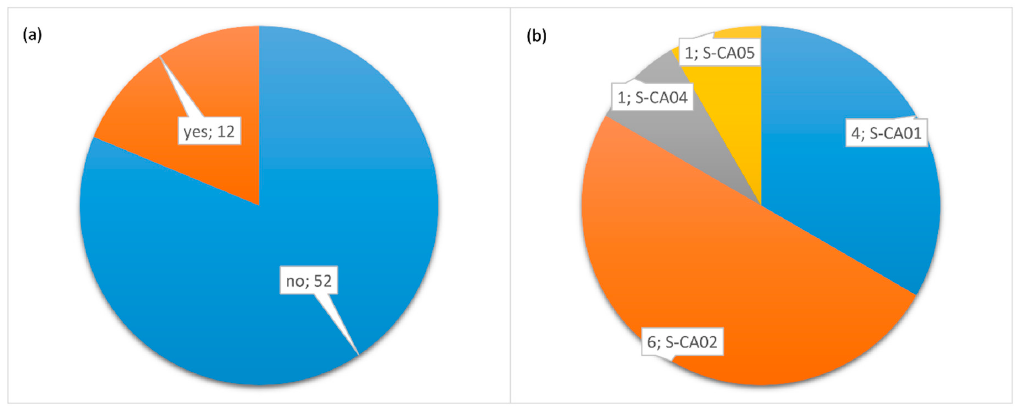
Figure 2. Distribution of workers affirming to know (“yes”) or not to know (“no”) the new eye lens dose limit ( a ), and distribution of yes-respondents across the hospitals ( b ).